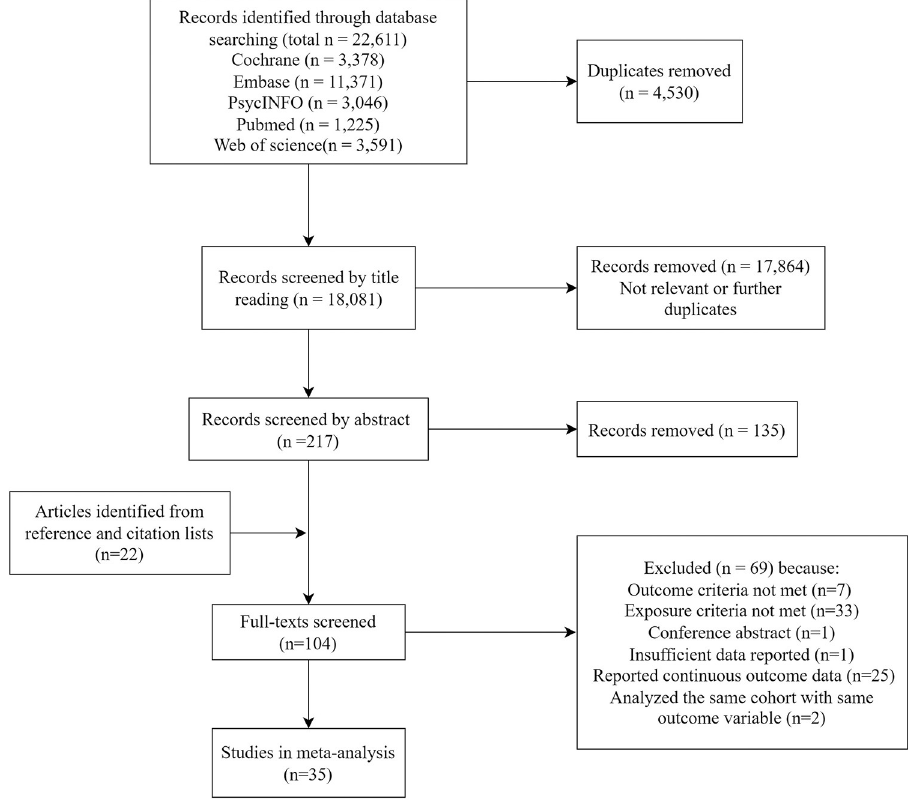
Fig 1. Study selection